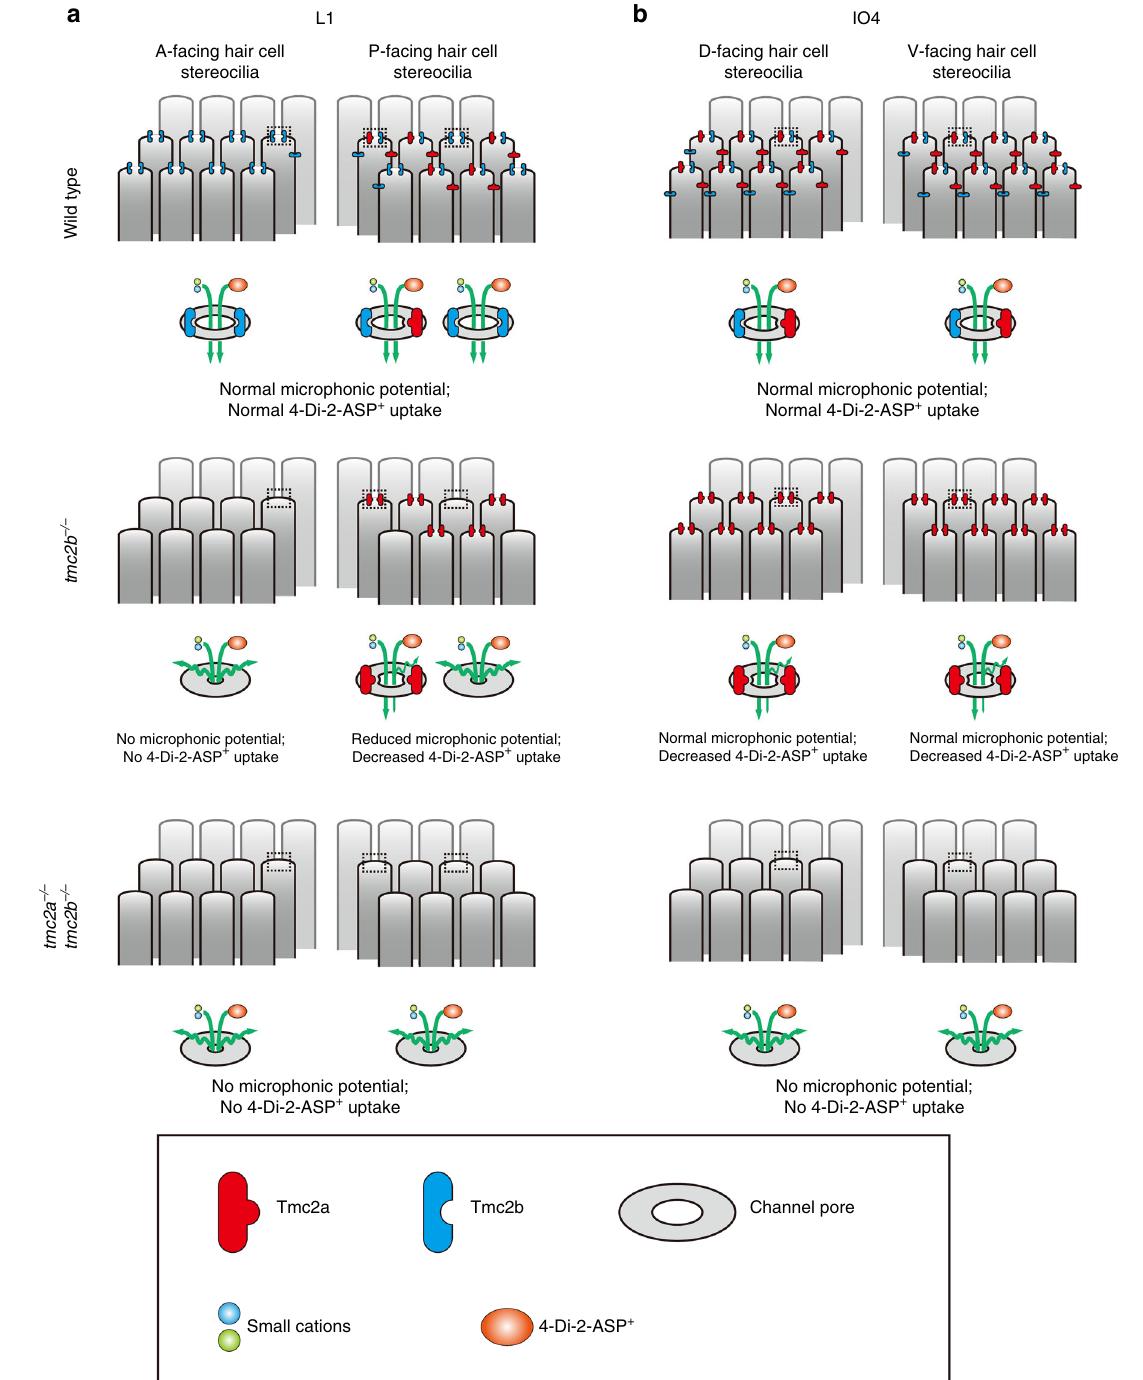
Fig. 9 Hypothetical roles of Tmc2b and Tmc2a in neuromast hair cells. a In wild-type fi sh, for one type of L1 neuromast variant, anterior-facing hair bundles depend completely on Tmc2b, but the posterior-facing hair cells depend on Tmc2b and a limited quantity of Tmc2a. In tmc2b − / − mutants, hair cells that take up fl uorophore predominantly face posteriorly and contribute to microphonic potentials. Asymmetric uptake and microphonic potentials may be due to limited Tmc2a compensation, which permits the decreased passage of fl uorophore and the diminished entry of small cations because fewer functional channels assemble. Those that do form have pores with decreased capacity for 4-Di-2-ASP entry. L1 hair cells do not function if they lack both Tmc2b and Tmc2a. b In wild-type fi sh, in this hypothetical model, each mechanotransduction apparatus of IO4 hair cells has a similar molecular composition irrespective of hair bundle orientation, in fl uenced by high levels of both Tmc2b and Tmc2a. In tmc2b − / − knockout fi sh, Tmc2a compensates for Tmc2b, resulting in a modest change in channel pore quality. IO4 hair cells do not function if they lack both Tmc2b and Tmc2a. Note, these models do not distinguish between Tmc2a and Tmc2b as accessory proteins of the mechanotransduction apparatus or as pore loop-containing channel subunits. They do however explain how mechanotransduction may be impacted by Tmc2a and